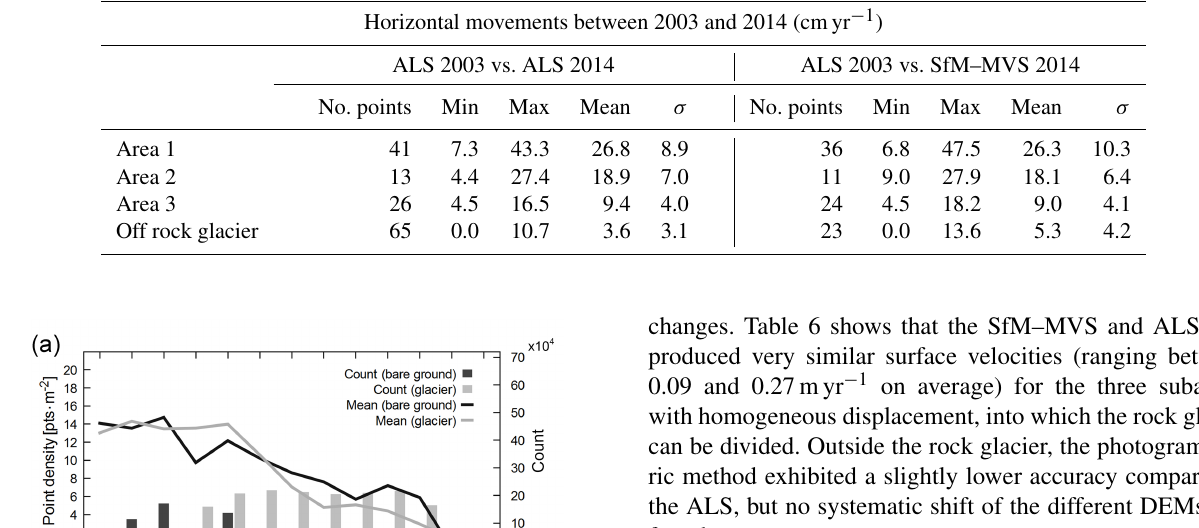
Table 6. Velocity statistics in three distinct areas of the rock glacier and in the stable area outside the rock glacier evaluated comparing the 2003 and 2014 ALS DEMs and the photogrammetric DEM for the 2014 survey epoch.